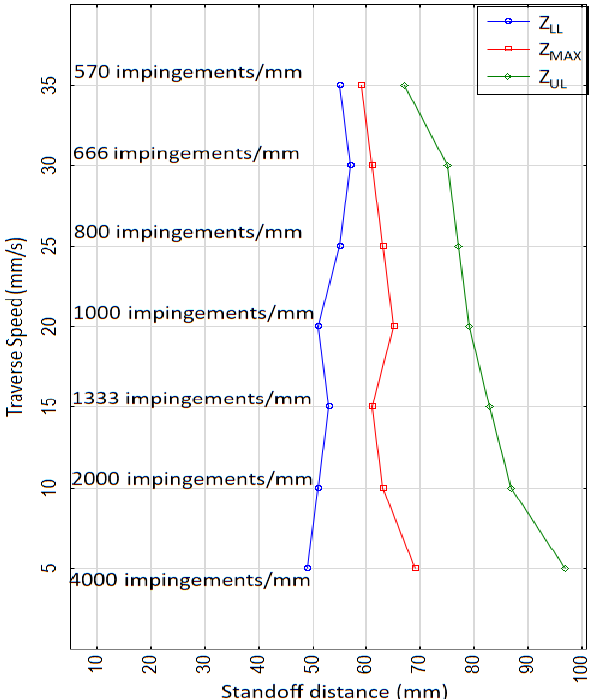
Figure 11. Variation in erosion interval with standoff distance ( z = 5 to 101 mm) and traverse speed ( v = 5 to 35 mm/s) at constant pressure ( p = 70 MPa).